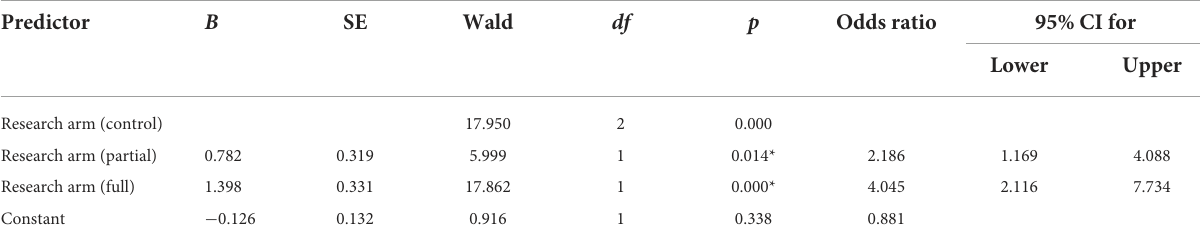
TABLE 8 Logistic regression results for egg consumption at endline based on HHDM-E across research arms. Logistic regression predicting likelihood of egg consumption at endline based on HHDM-E across research arms